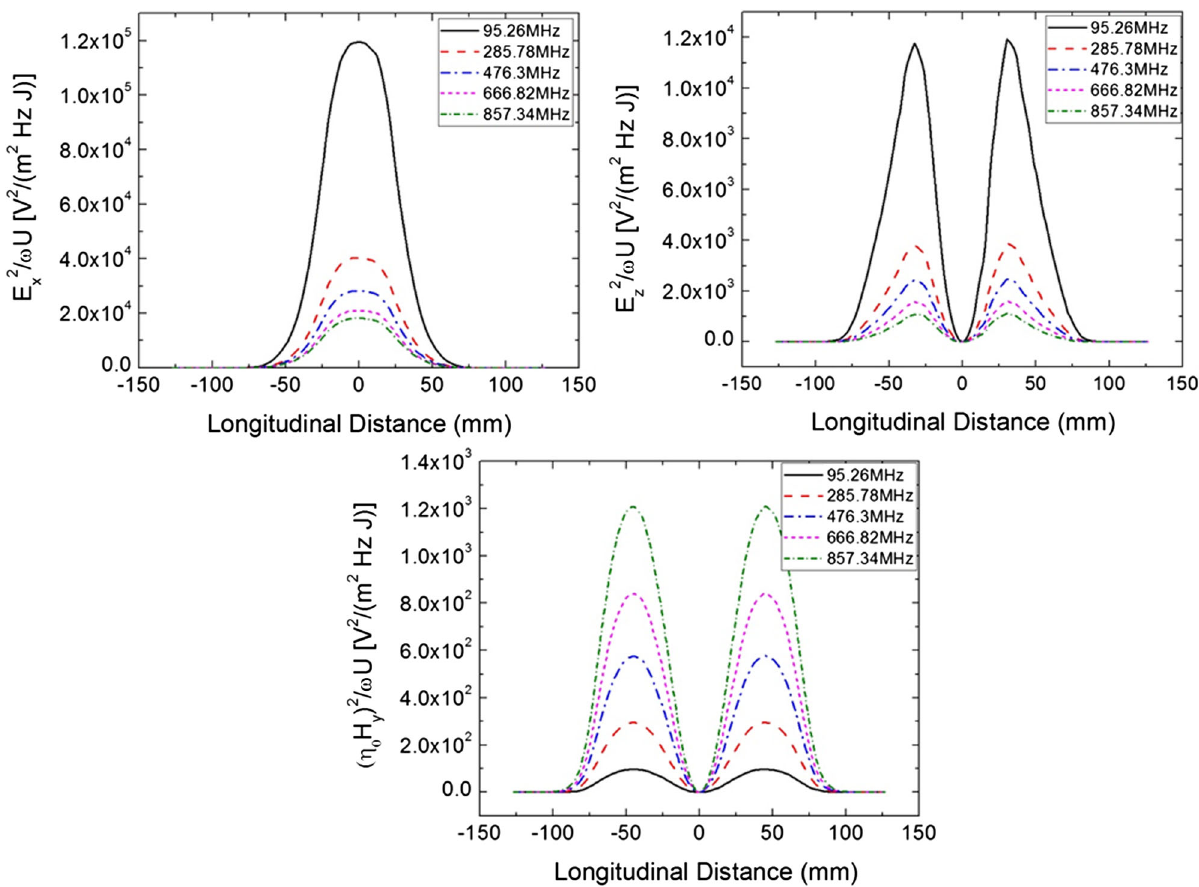
FIG. 16. On-axis field magnitude square of the different components of the electric field E magnetic field H (bottom). The magnetic field is multiplied by the free space impedance ( η 0 ¼ 120 π ) to give a fair comparison of the y respective contribution of the electric and magnetic field to the transverse kick. All these electromagnetic fields are normalized to 1 J stored energy.